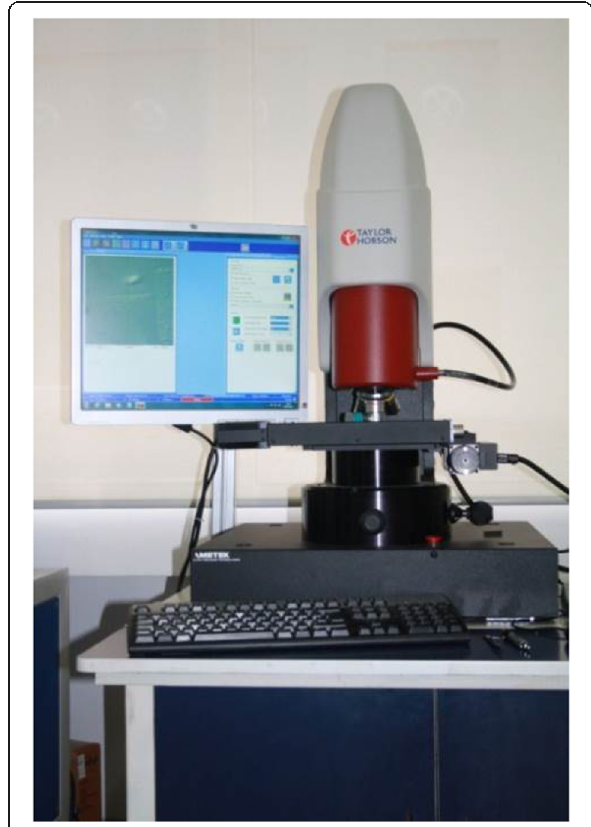
Fig. 2 3D surface profilometer machine (Taylor